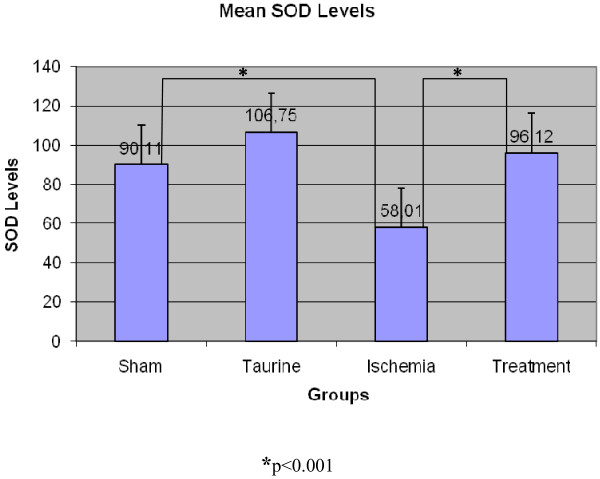
SOD enzyme levels in rat myocard tissue.